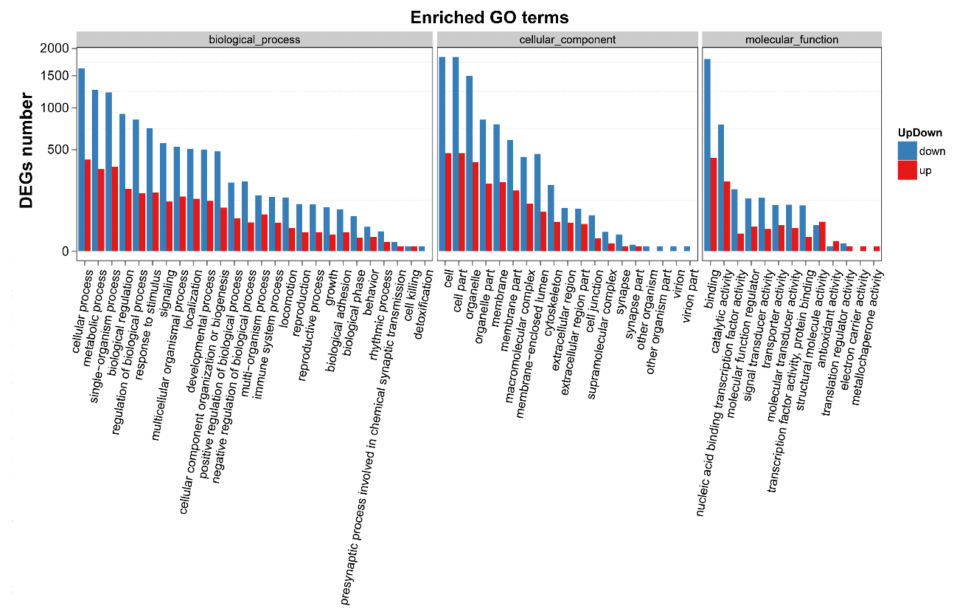
Figure 8. GO functional classifications of DEGs after SPPH treatment. The x -axis indicates the GO terms, and the y -axis indicates the number of DEGs. GO terms were grouped into three ontologies: biological process, cellular component and molecular function. Down- and up-regulated genes are presented in blue and red,